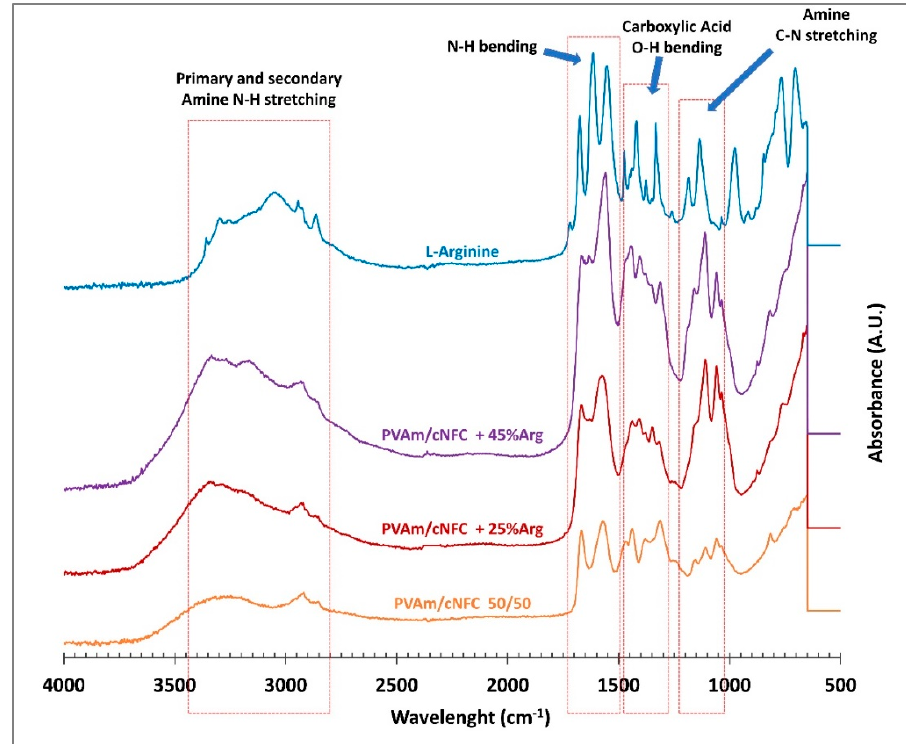
Figure 4. FTIR spectra of ternary PVAm/cNFC+Arg blends, Spectra of binary PVAm/cNFC blend and of L-arginine are also reported for comparison.